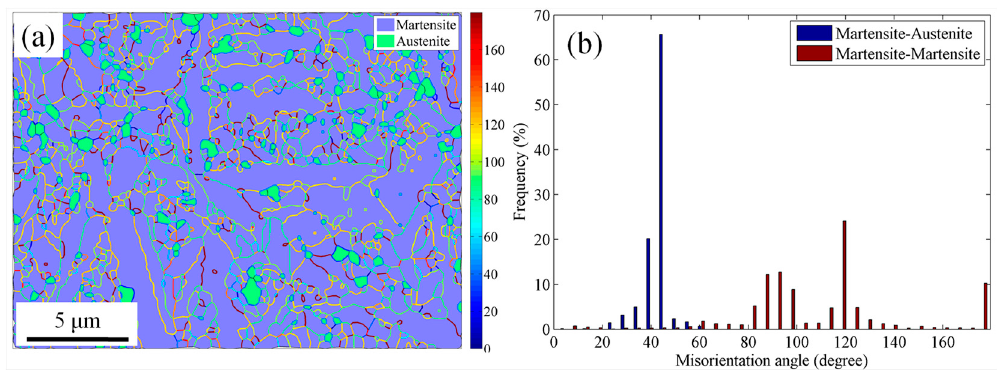
Figure 6. EBSD maps of Ni-50 at % Ti SMA: ( a ) microstructure; ( b ) frequency distribution of misorientation angle.